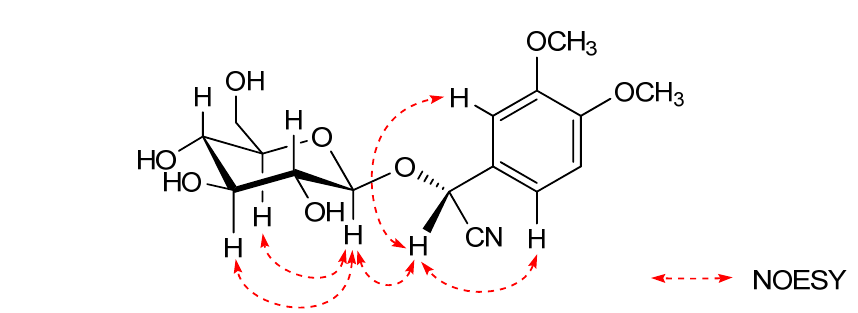
Figure 3. Key NOESY correlations of compound 1